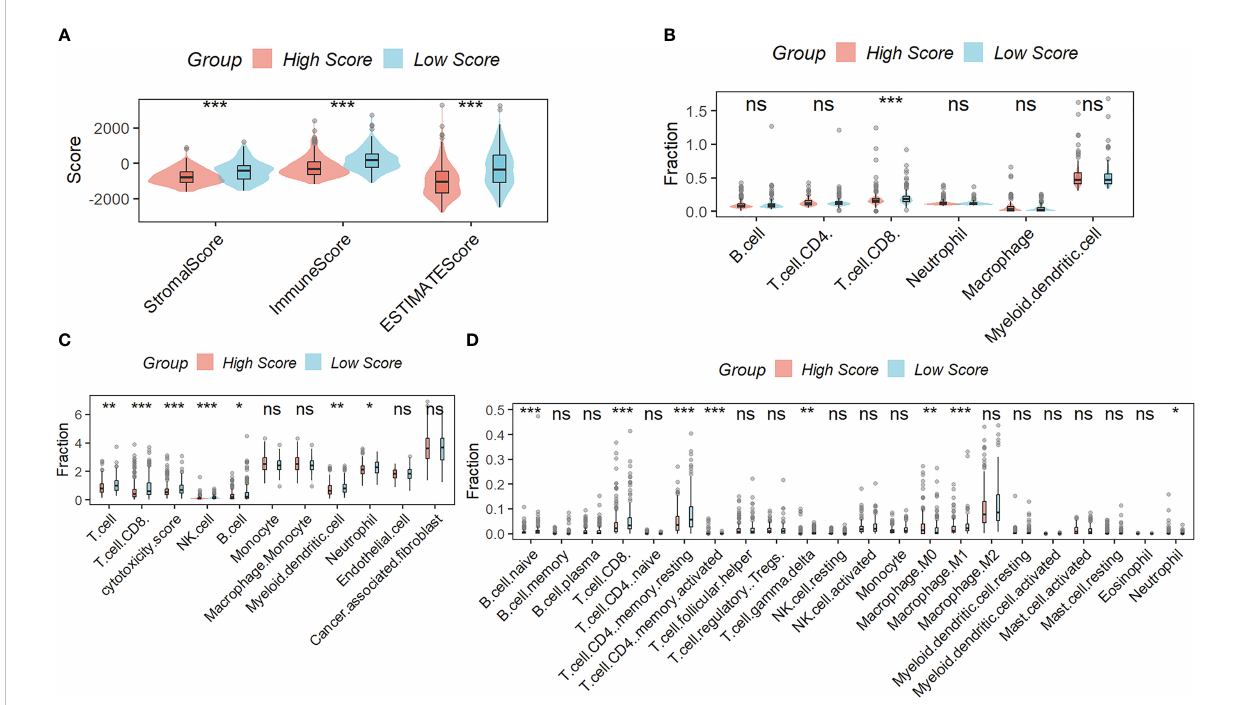
FIGURE 5 Correlation Analysis between the signature and immunity. (A) samples in the low-scoring group had higher immune, stromal, and ESTIMATE scores compared to samples in the high-scoring group. The difference in the percentage of immune cell in fi ltration in different molecular subtypes was analyzed by the TIMER (B) , MCPcounter (C) , and CIBISORT (D) . ns, not signi fi cant; *p < 0.05; **p <0.01; ***p <